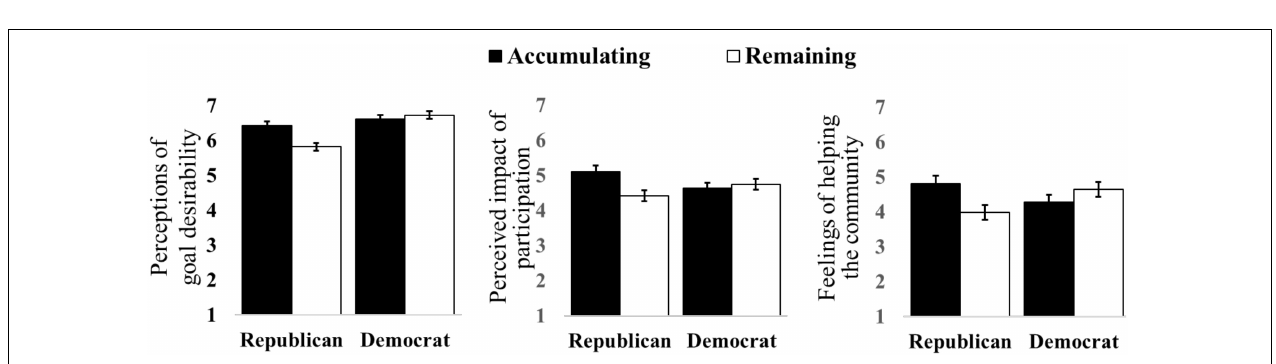
FIGURE 2 | Study 1 Results: Collective progress framing by political affiliation for perceptions of goal desirability (left) , perceived impact of participation (center) , and feelings of helping the community (right)